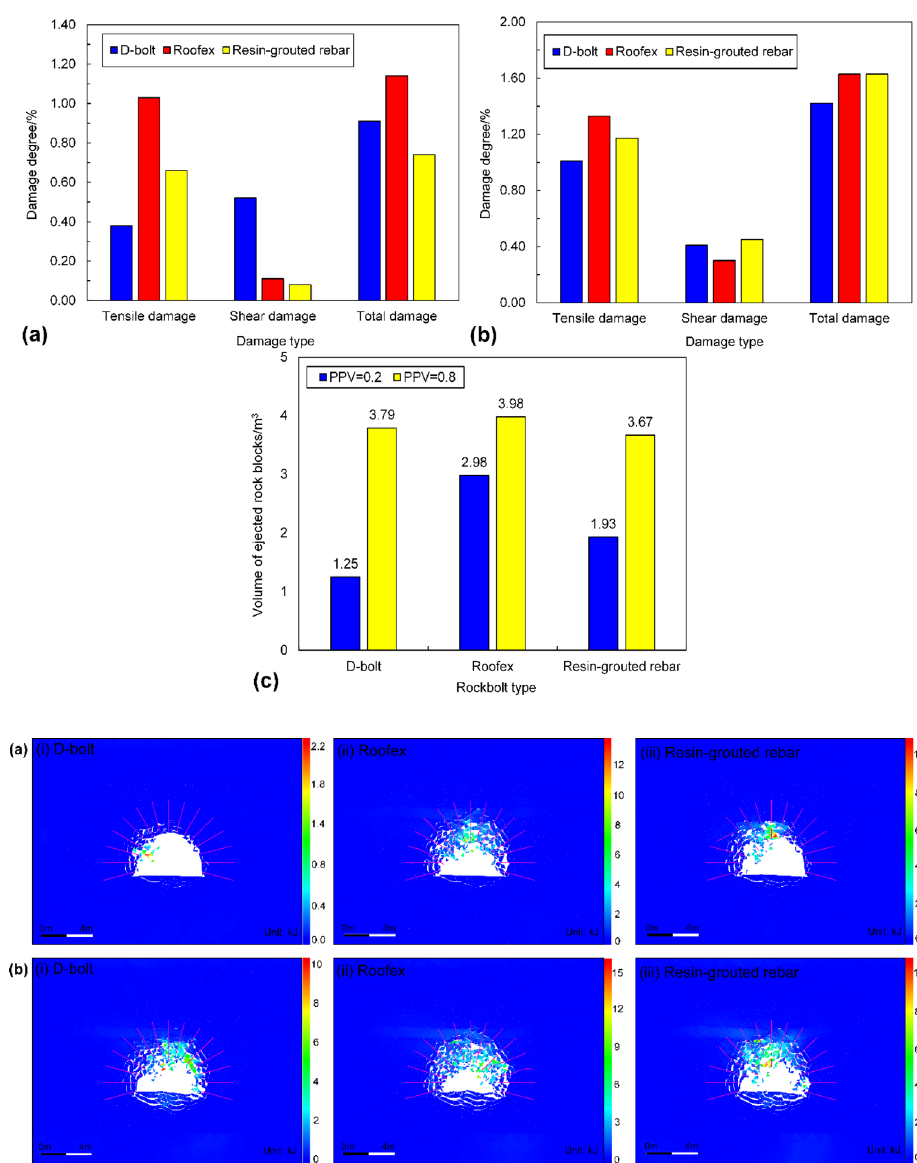
Fig. 18 a and b are the damage degrees of the tunnel when the PPVs are 0.2 and 0.8 m/s, respec- tively; c is the volume of ejected rock blocks of the tunnel induced by